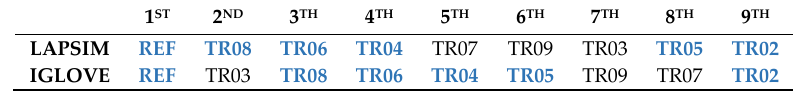
Figure 2. Examples of curves of apprenticeship, parameter task duration, ( a ) IGlove, ( b ) LapSim. Table 2. Comparison of ranking using all the parameters (blue: similar ranks, REF: expert